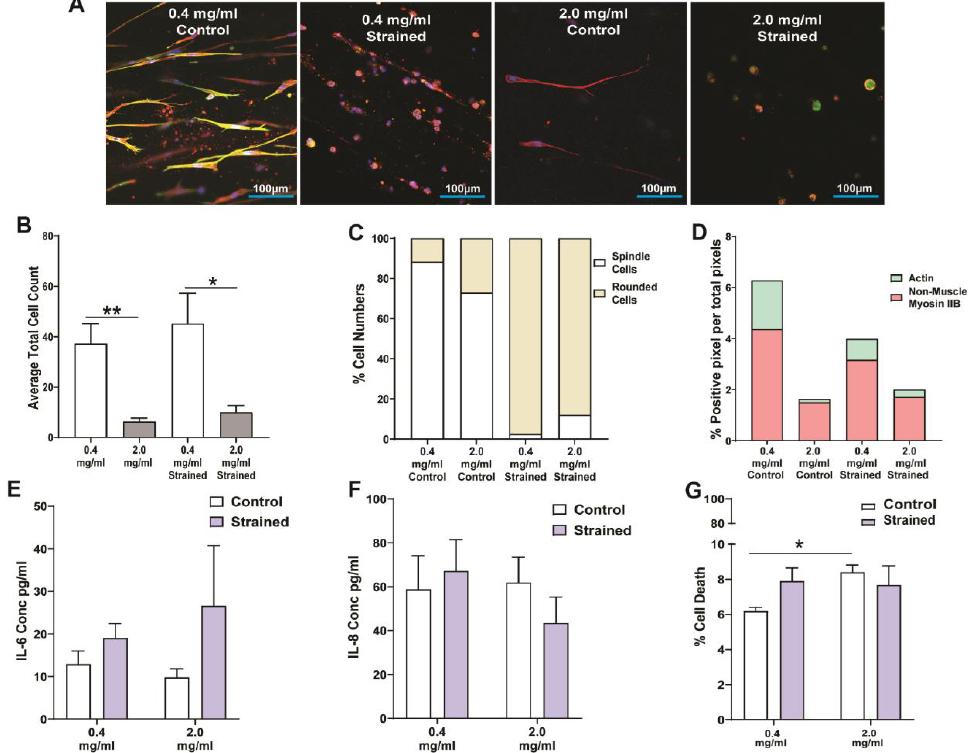
Figure 4. Response of lung fibroblasts to mechanical strain within a 3D collagen-I microenvironment. Human fetal lung 1 (HFL1) fibroblasts were embedded in 3D collagen-1 gels of 0.4 mg/mL and 2.0 mg/mL concentrations and cultured for 24 h. The HFL1 fibroblast-seeded collagen gels were then left alone or mechanically strained for 48 h at a 1% amplitude and a frequency of 0.2 Hz. ( A ) Representative confocal images of HFL1 fibroblasts in 0.4 mg/mL and 2.0 mg/mL collagen-1 gels stained for non-muscle myosin IIB (red) and F-actin (green) after mechanical strain experiments. ( B ) Average total cell counts in 0.4 mg/mL and 2.0 mg/mL collagen-1 gels after strain or no strain for 48 h. (C) Percentage cell numbers of spindle and rounded shaped cells in 0.4 mg/mL and 2.0 mg/mL collagen-I gels after strain or no strain for 48 h. ( D ) Percentage positive pixel count per total number of pixels in images of 0.4 mg/mL and 2.0 mg/mL collagen-I gels after strain or no strain for 48 h. ( E ) Percentage positive pixel count per total number of pixels in images of 0.4 mg/mL and 2.0 mg/mL collagen-I gels after strain or no strain for 48 h. The concentration of ( F ) IL-6 and ( G ) IL-8 cytokines released from HFL1 fibroblasts in 0.4 mg/mL and 2.0 mg/mL collagen-1 gels after strain or no strain for 48 h. ( G ) The percentage of cell viability of HFL fibroblasts in 0.4 mg/mL and 2.0 mg/mL collagen-I gels after strain or no strain for 48 h. Mean ± SEM indicated for 3 technical replicates, n = 6. * p < 0.05, and ** p < 0.01.